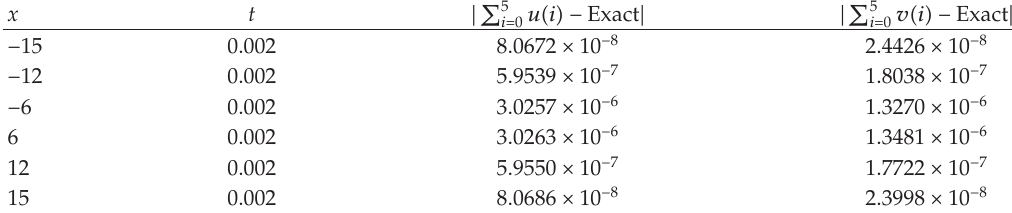
Table 2: The comparison of the results of the HAM (cid:3) h (cid:8) − 1 (cid:4) and exact solution for the u (cid:3) x,t (cid:4) , α (cid:8) β (cid:8) 1. x